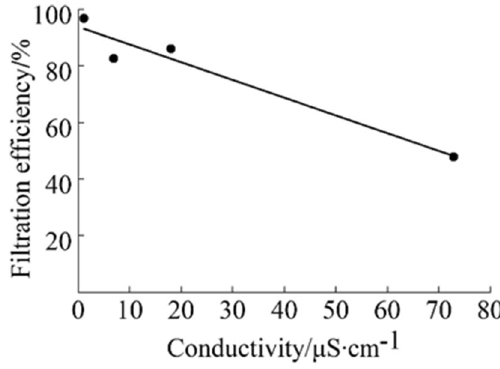
Figure 3. The influence of water conductivity on the filtration efficiency of